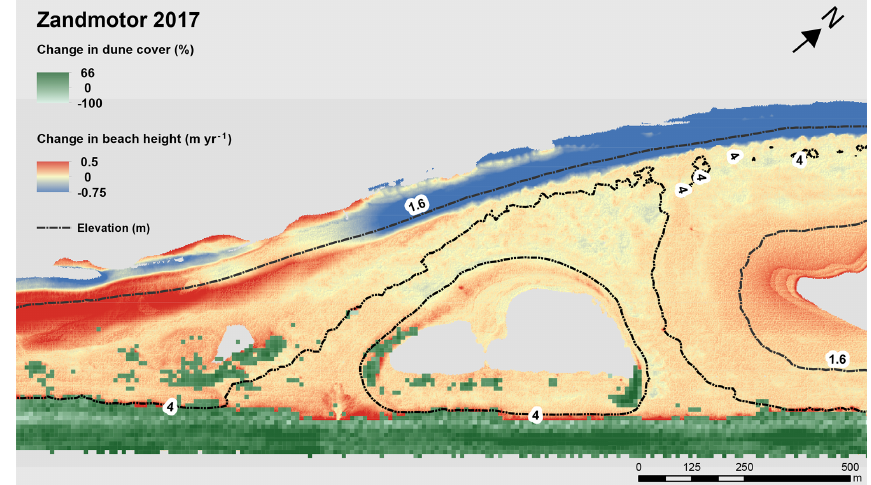
Figure 8. The distribution of (embryo) dunes on the Zandmotor , suggesting a correlation to marine dispersal of rhizome fragments as a large number of embryo dunes are present between the identified boundary height of 1.6ma.m.s.l. and the (current) maximum expected storm surge height of